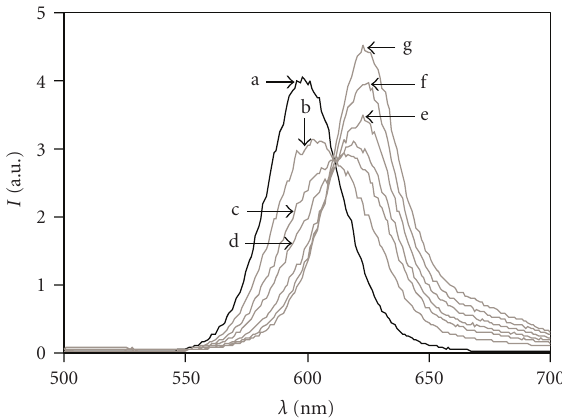
Figure 5: Emission spectra of a dispersion of CdSe-ZnS core-shell QDs (0.1 μ M) and His 6 -PDK1( Δ PH) (10 μ M) in borate bu ff er (pH = 7.4, T = 20 ◦ C, λ = 442nm) in the absence (a) and presence of 1.0 EX (b), 3.0 (c), 5.0 (d), 10.0 (e), 20.0 (f), and 30.0 (g) μ M of BODIPY-